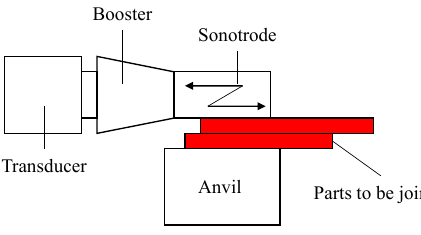
Figure 3. Scheme of metal ultrasonic welding.